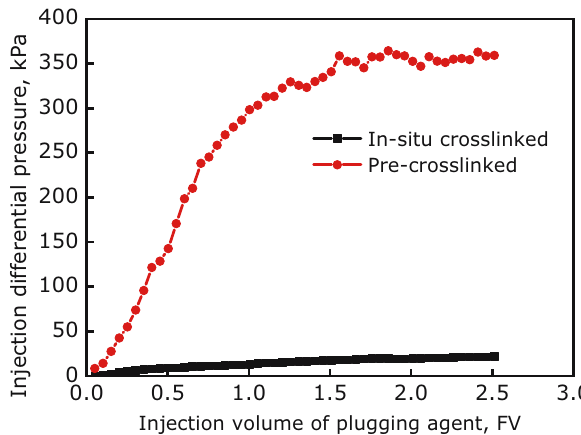
Figure 11: Injection di ff erential pressures of gel solution in the case of in situ cross - linking and pre - cross - linking.